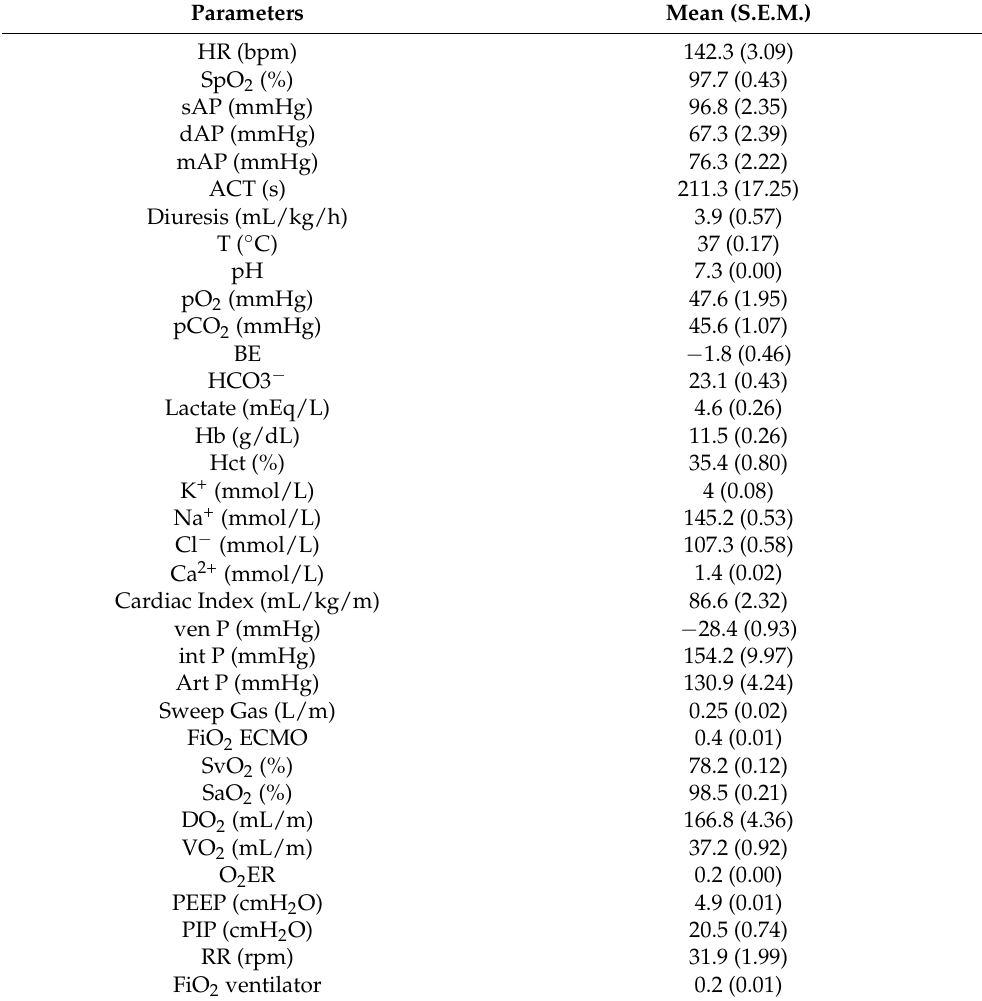
Table 1. Physiological characteristics during extracorporeal membrane oxygenation (ECMO). Parameters Mean